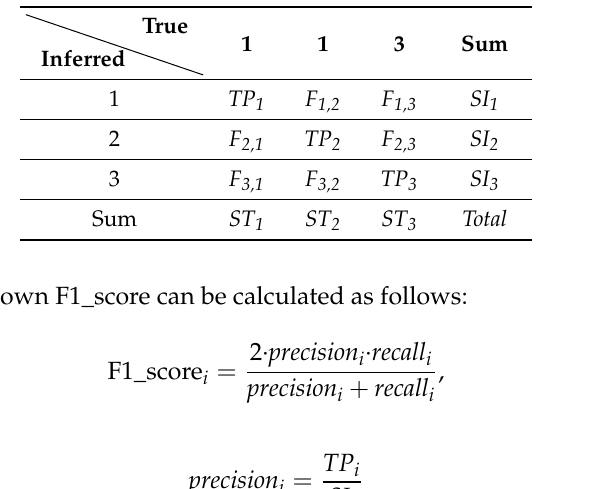
Table 3. Multi-classes confusion matrix, the number 1, 2 and 3 denote three di ff erent